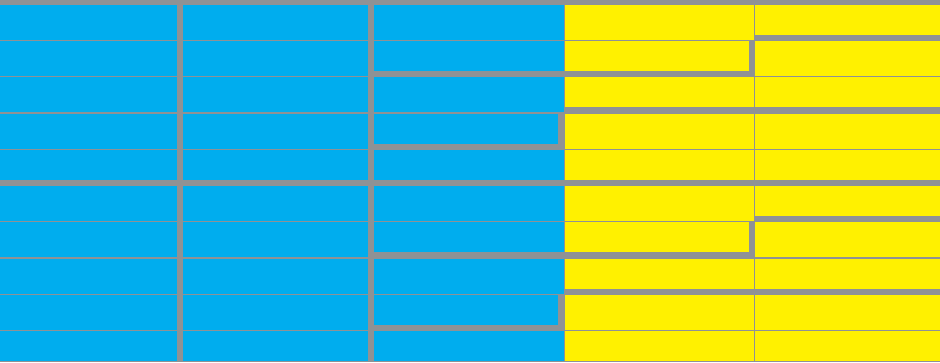
Table 2 imposes a (re)districting plan upon our reference polity, Table 1. The Table 2 plan is not a gerrymander, at least for partisan advantage. The Cyan (Yellow) party has 60% (40%) of the voters and dominates in 60% (40%) of the districts. In the plan of Table 3, all 10 districts have a comfortable 60% majority for the Cyan party, which could be be expected to take 100% of the seats, that is, all ten of them, leaving none for the Yellow party even though its voters constitute 40% of the population. This plan, in conse- quence, embodies a partisan advantage favoring the Cyan party. It would normally be consid- ered a partisan gerrymander, something the Cyan party would do if it had the power. Table 4. Fifty precincts, 30 Cyan, 20 Yellow. Of the ten districts, 4 are fully Cyan, 6 have a Yellow majority, suggesting a gerrymander in favor of Yellow.